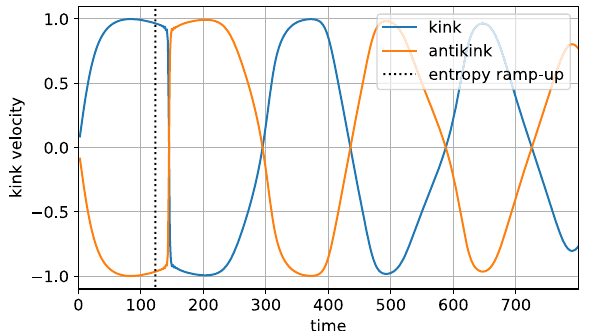
FIG. 25. Kink and antikink wavepacket velocity for the Ising model, simulation (i) of the main text, computed as the finite dif- ference of the interpolated position of the 0-intercept of (cid:2) Z j (cid:3) . The bond dimension is 128. Note that the data are only likely to be accurate up to t ≈ 800, as suggested by Fig. 11. The onset of the first collision is indicated by the dotted line, which is the time at which the maximum cut entropy begins to grow